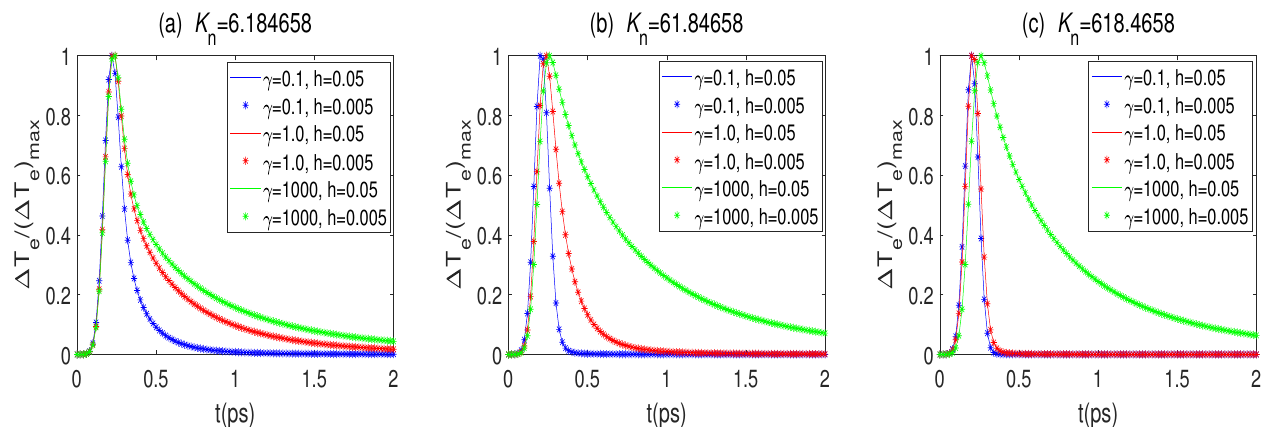
Figure 5. Changes in electron temperature ∆ T e / ( ∆ T e ) max and various K n , γ , and ( α , β ) = ( 0.9,0.3 ) .